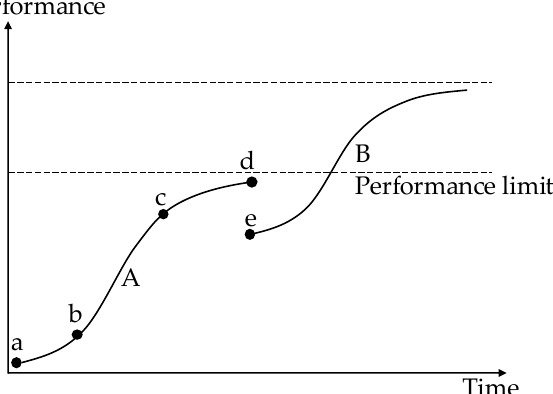
Figure 7. Technology Life Cycle Curve. Adapted with permission from Ref. [25]. 2021, Elsevier.